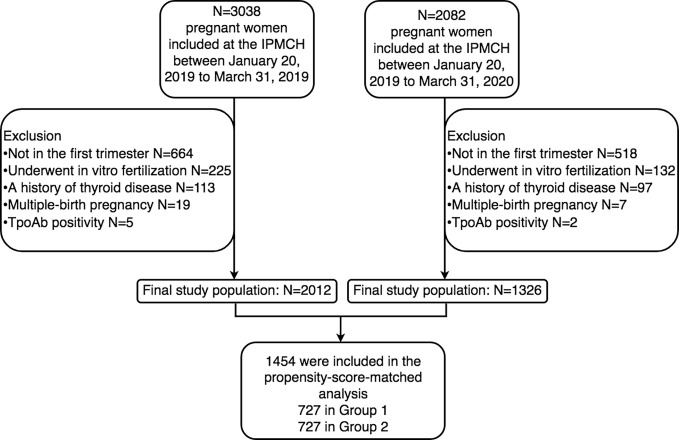
Flowchart illustrating study population selection and data availability.